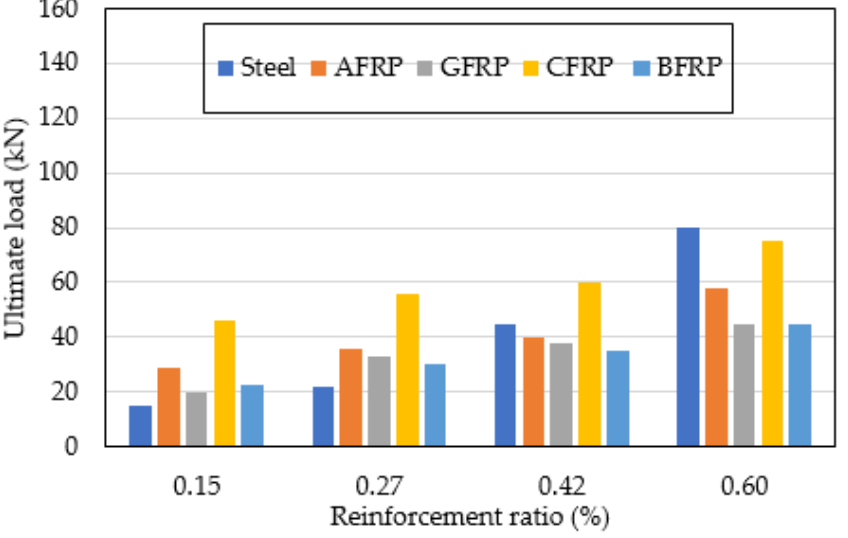
Figure 10. Load vs. Reinforcement ratio.